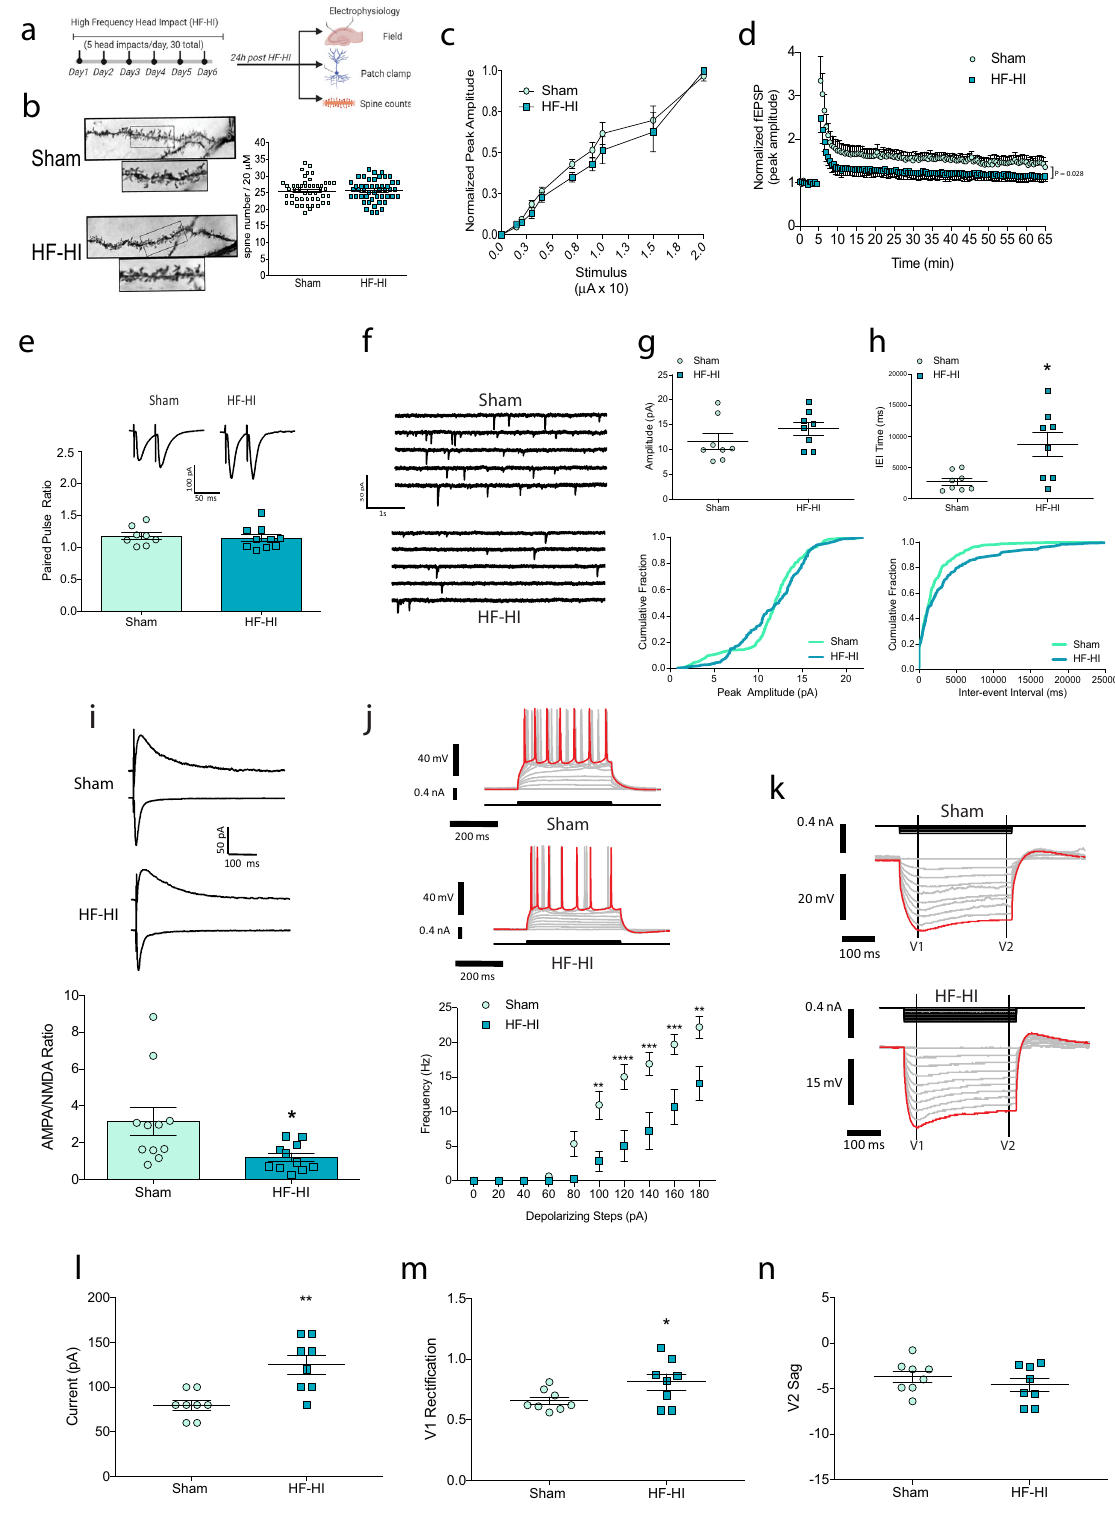
2.861; P = 0.0387) and time in the target zone (F (3, 160) = 3.486, P = 0.0172) with post hoc analysis revealing reductions in HF- HI mice compared to sham ( P < 0.05) (Fig. 3l, m). Collectively, these data demonstrate that HF-HI induces chronic cognitive de fi cits in mice. As described earlier, 1 month mice lacked in fl ammatory phenotypes in all brain areas